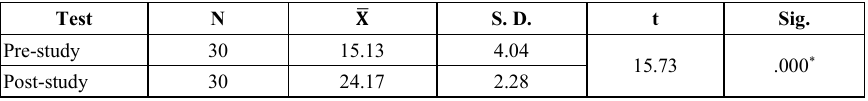
Table 6. Comparison of learner s’ learning achievement concerning pre-post study Level 2 – Digital